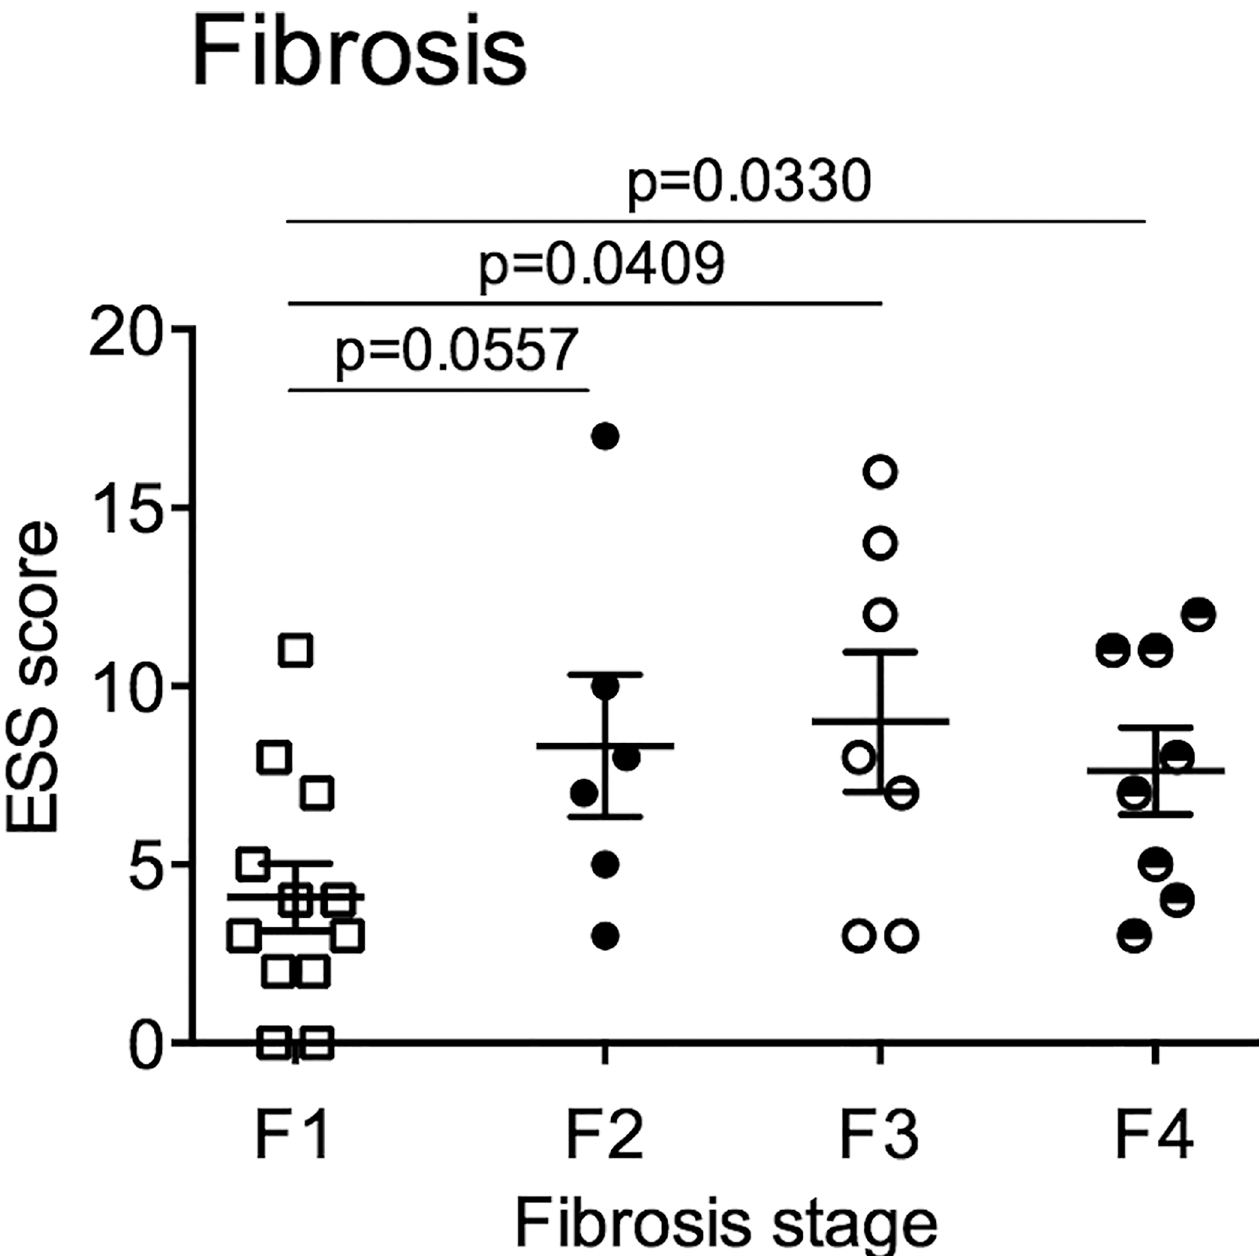
Fig 4. Daytime sleepiness is higher in patients with advanced fibrosis. Daytime sleepiness, assessed by the Epworth Sleepiness scale (ESS) was plotted against the stage fibrosis (NAFLD activity score) in patients with fibrosis (F1-F4). * , p <